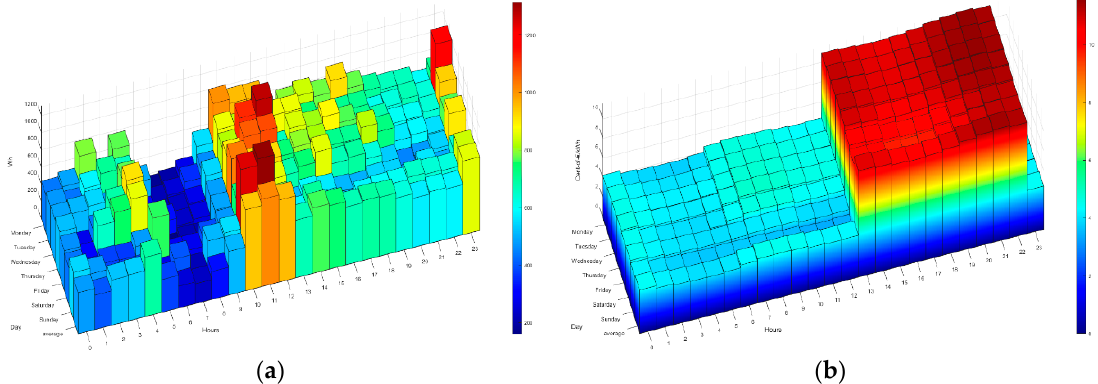
Figure 17. P3. ( a ) Average consumption (Wh) and ( b ) average prices (€ cents per kWh) during the third period from 29